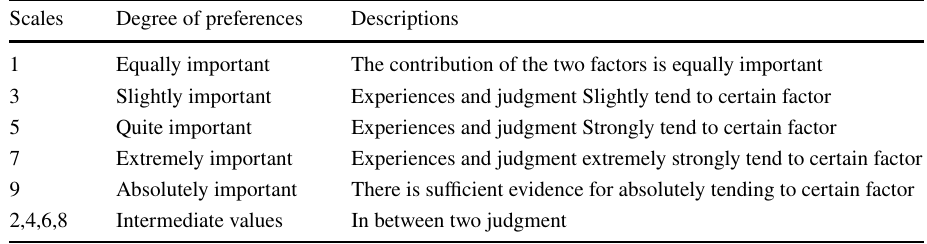
Table 3 Pair-wise comparison matrix for all factors